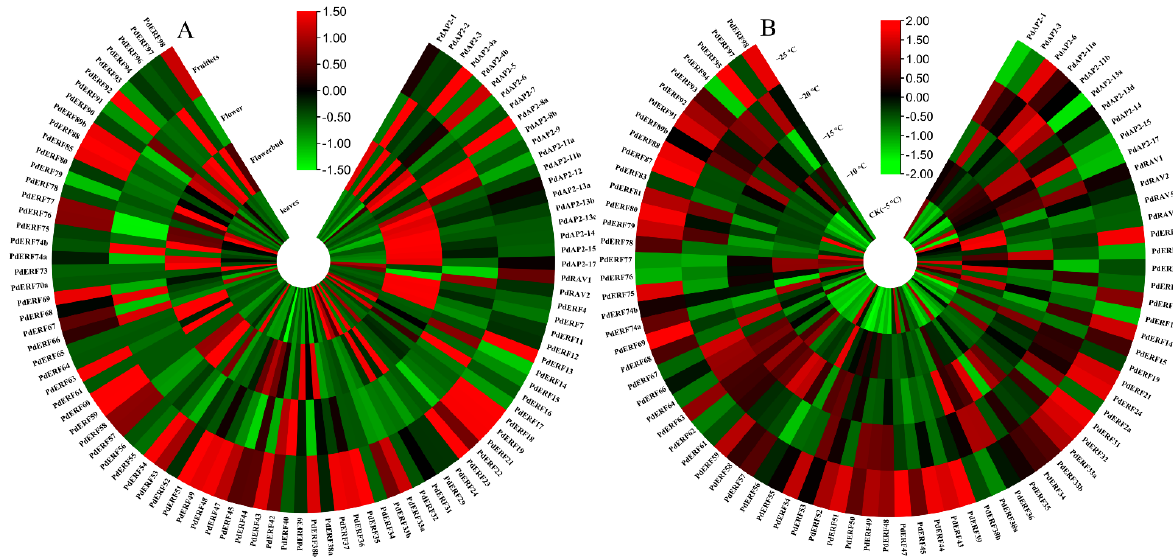
Figure 7. Heatmap of the expression patterns of PdAP2/ERF gene family members. ( A ): Heatmap of expression patterns in different tissues. ( B ): Expression heatmap of annual dormant branches under freezing stress at different temperatures. The ROW normalization method was used to draw the heatmap. Red squares indicate upregulation of expression, black squares indicate no expression, and green squares indicate downregulated expression.